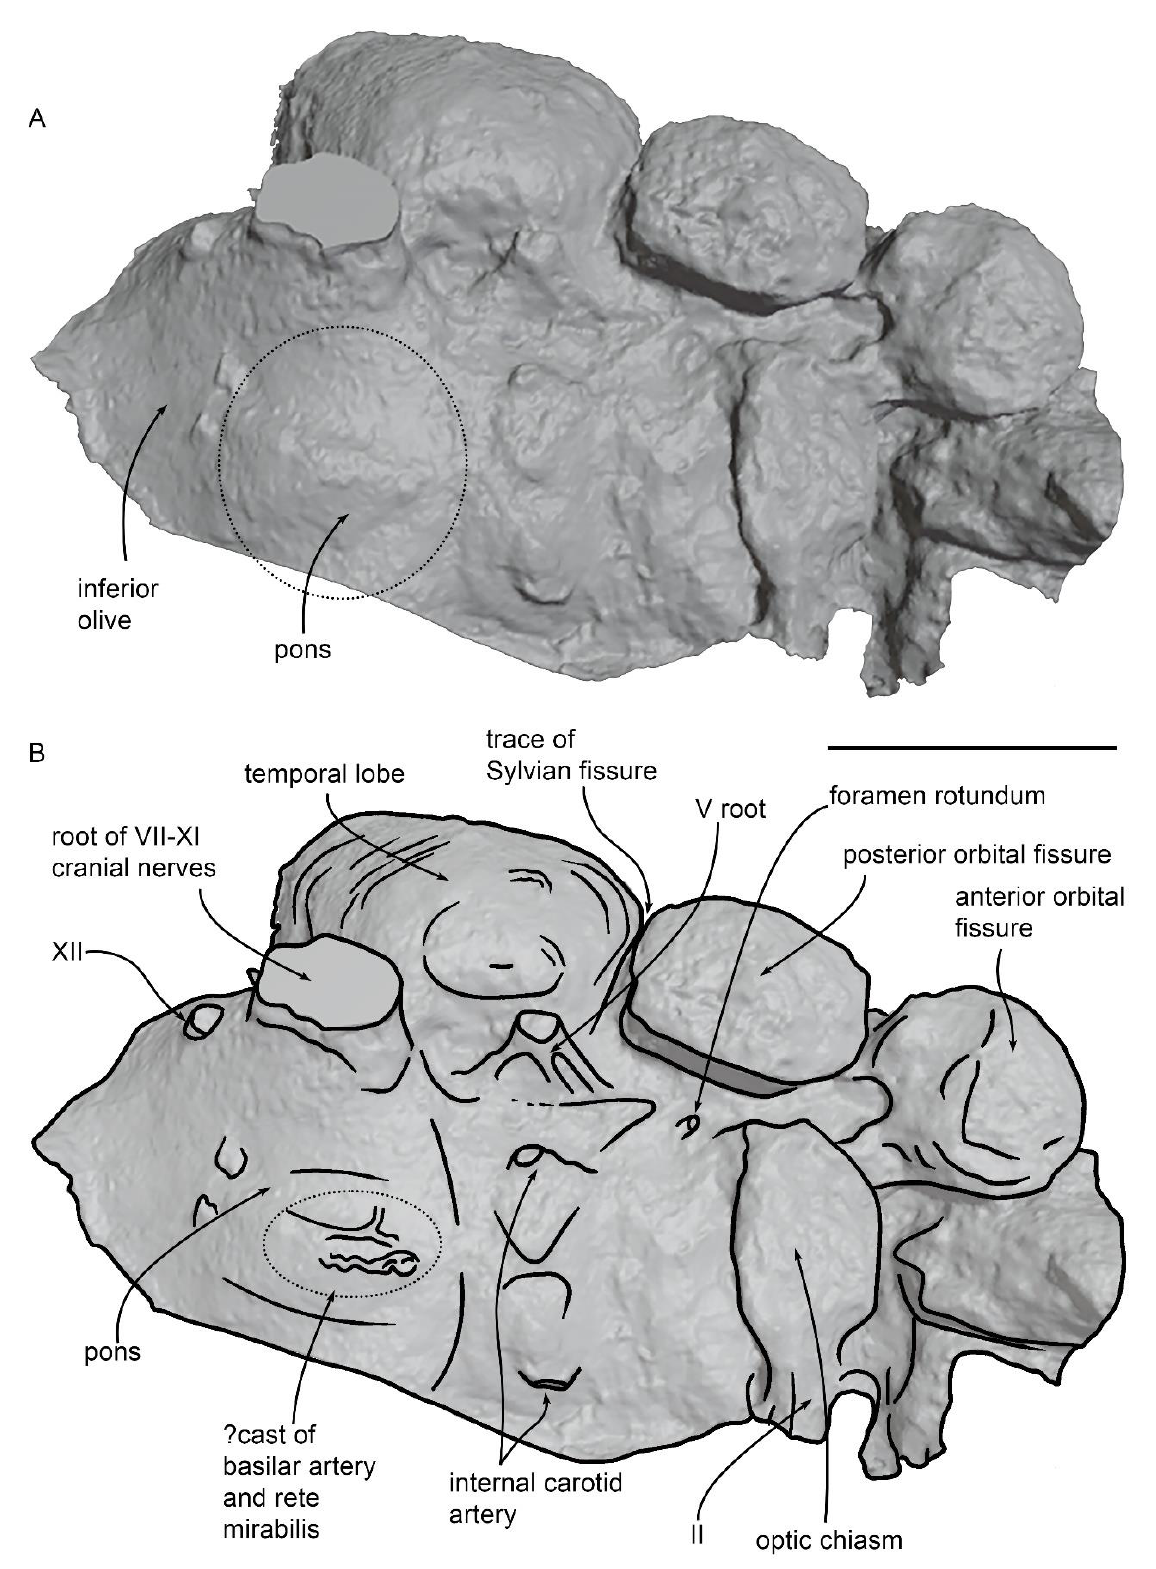
Figure 14. Virtual endocast of MGPT-PU 13881/1 showing the ventral surface of the brain. ( A ) Software representation. ( B ) Anatomical interpretation. Scale bar equals 5 cm.